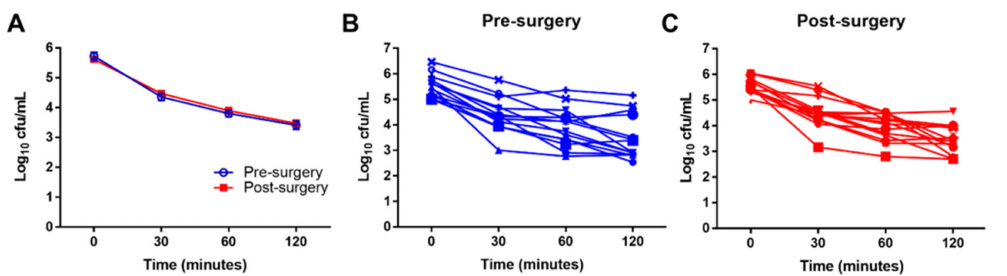
Figure 6. Surgery does not impair leukocyte bactericidal activity. S. aureus whole blood killing assays were performed from blood collected from patients pre- and post-surgery for THA and TKA ( n = 14). Numbers of viable bacteria are reported as Log 10 colony forming units (cfu) per mL for ( A ) the average killing for all patients pre- and post-arthroplasty and stratified into ( B ) pre-surgery and ( C )